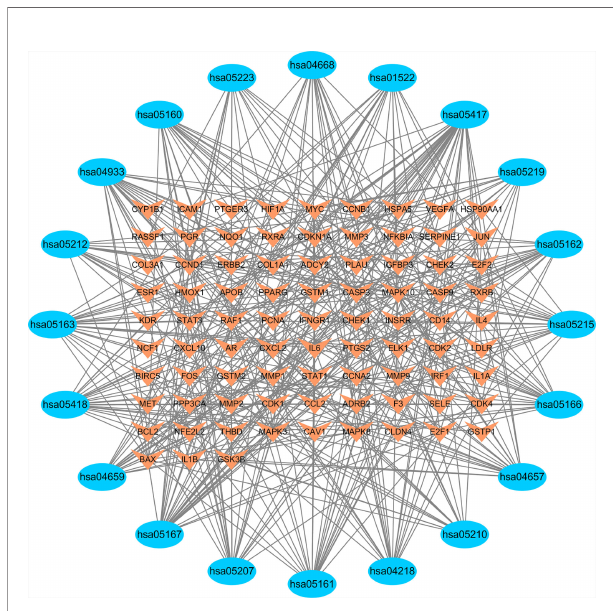
FIGURE 15 | KEGG regulatory